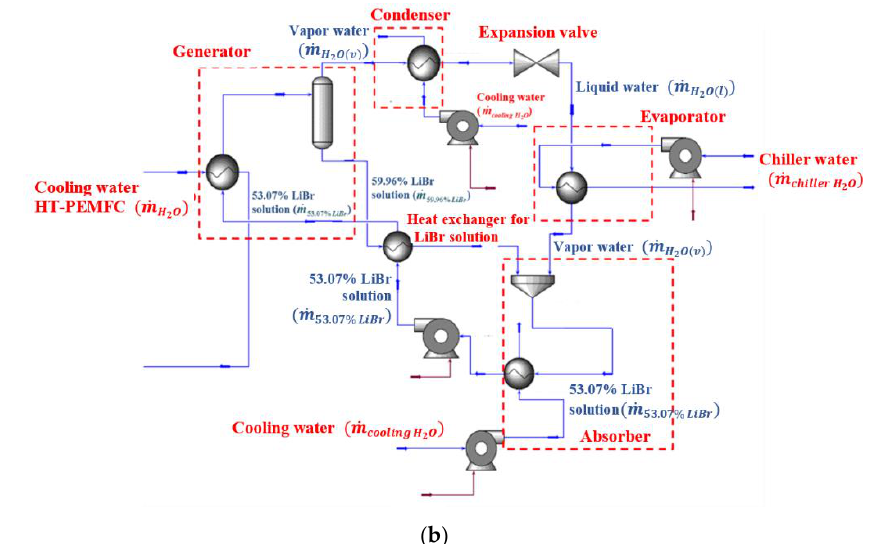
Figure 4. ( a ) Configuration of the absorption chiller using LiBr –H 2 O solution and ( b ) related flowsheet created by ASPEN HYSYS ® .